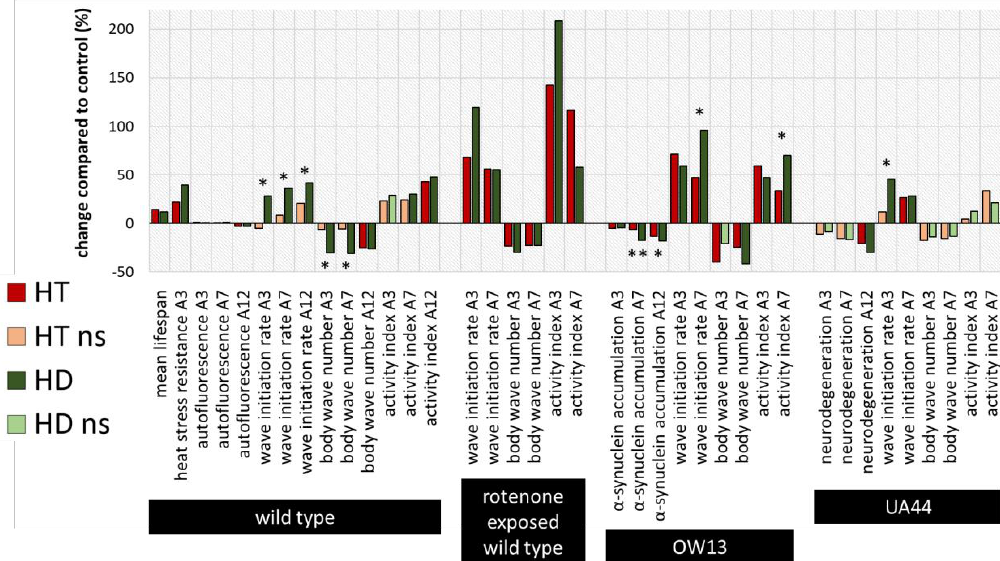
Figure 7. Summarized percentage changes after polyphenol treatment in all bioassays. The graph shows the percentage changes in all measured parameters compared to the respective control. Dark red (HT) and dark green (HD) bars represent significant ( p < 0.05 or p < 0.001) and light green or red bars non-significant (ns) differences to the control. In addition, the differences between the HT- and HD-treated groups were statistically determined and the differences between the treated groups were considered significant at p < 0.05 (*) and p < 0.001 (**). Due to the distinct performance of the assays with temporal distance and separate control-groups, no direct comparison of HT and HD was conducted for the lifespan and heat stress resistance assy. A3, A7, A12: 3rd, 7th and 12th day of adulthood.